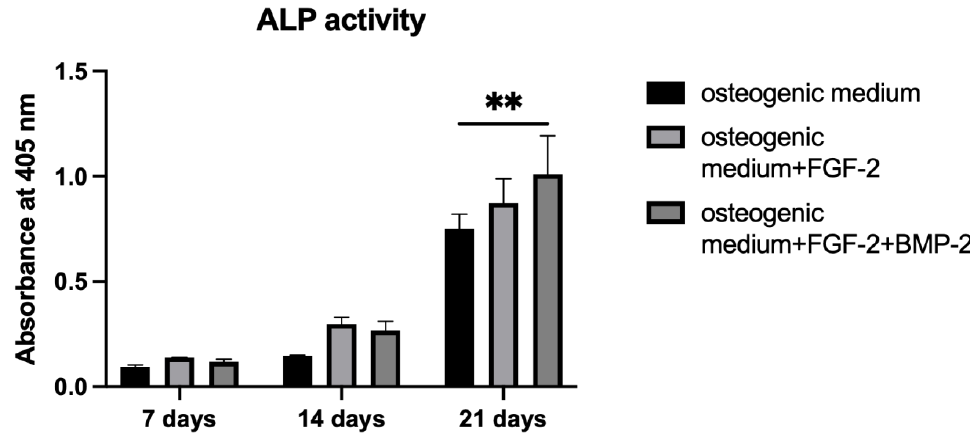
Figure 8. ALP activity of BM-MSCs grown on an nHAP-coated PCL/HAP/β -TCP scaffold treated or untreated with only FGF-2 or FGF-2 and BMP-2. ALP activity measured at 405 nm significantly increased for all culture conditions on day 21. The highest ALP activity was observed for FGF-2- and BMP-2-treated cells. The ALP assay was repeated in three independent experiments in duplicate each. ** p < 0.005.